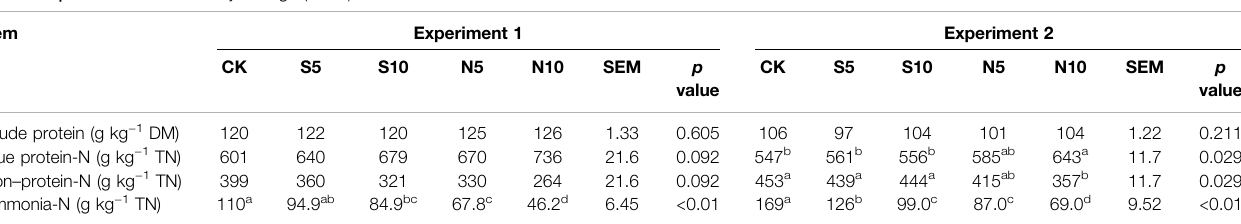
TABLE 3 | Protein fractions of stylo silage ( n = 3).